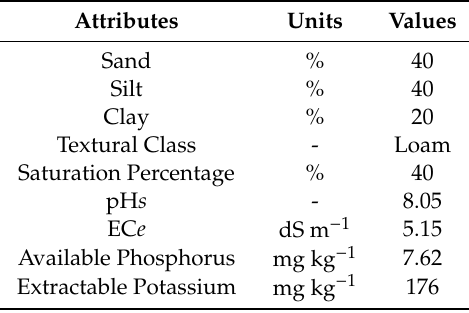
Table 1. Characteristics of experimental soil.